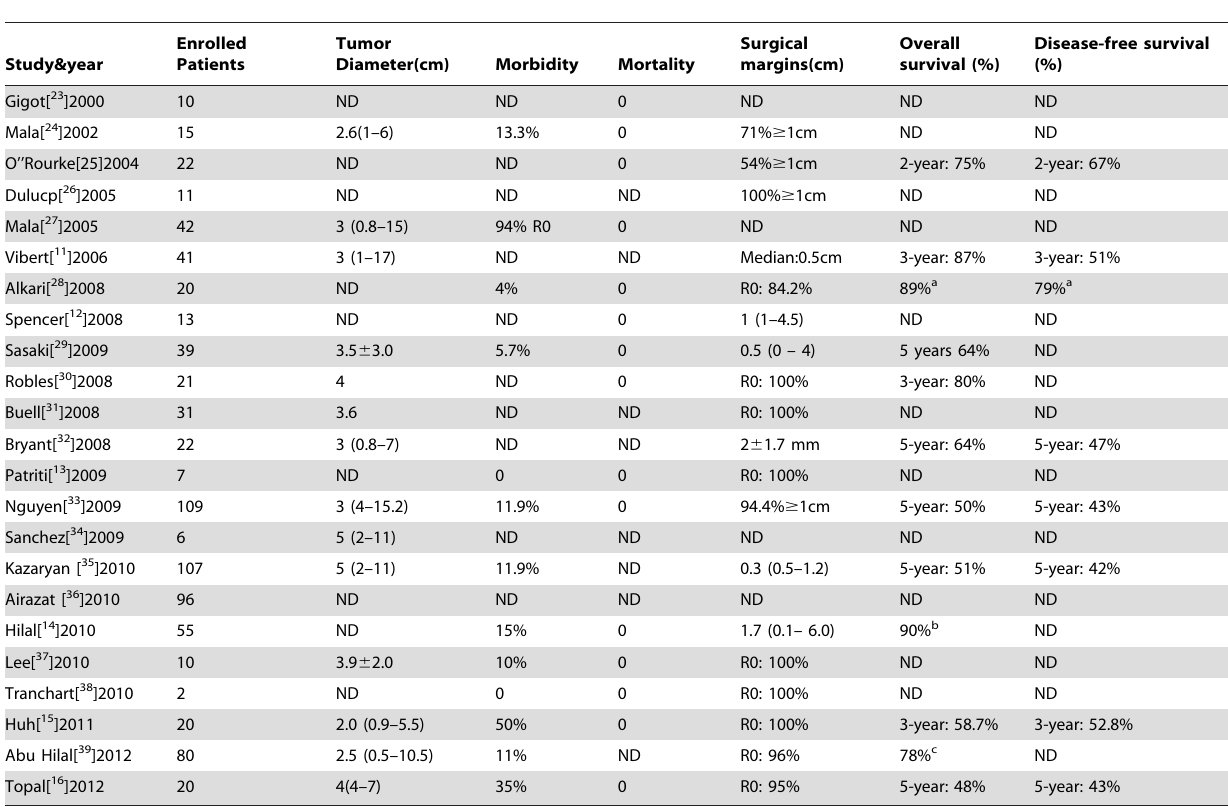
Table 4. Clinicopathologic of patients who underwent laparoscopic liver resections for colorectal liver metastases searched from Pubmed